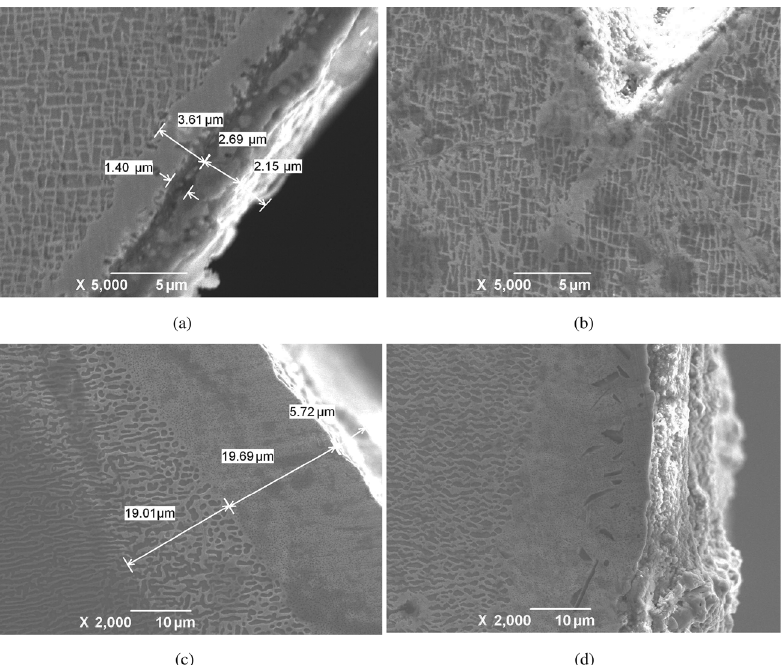
Figure 8: The oxide morphology near the fracture surface. (a) δ = 0.3 mm, 760 ℃ /830 MPa; (b) 1.2 mm, 760 ℃ /830 MPa; (c) δ = 0.3 mm, 1,100 ℃ /200 MPa and (d) 1.2 mm, 1,100 ℃ /200